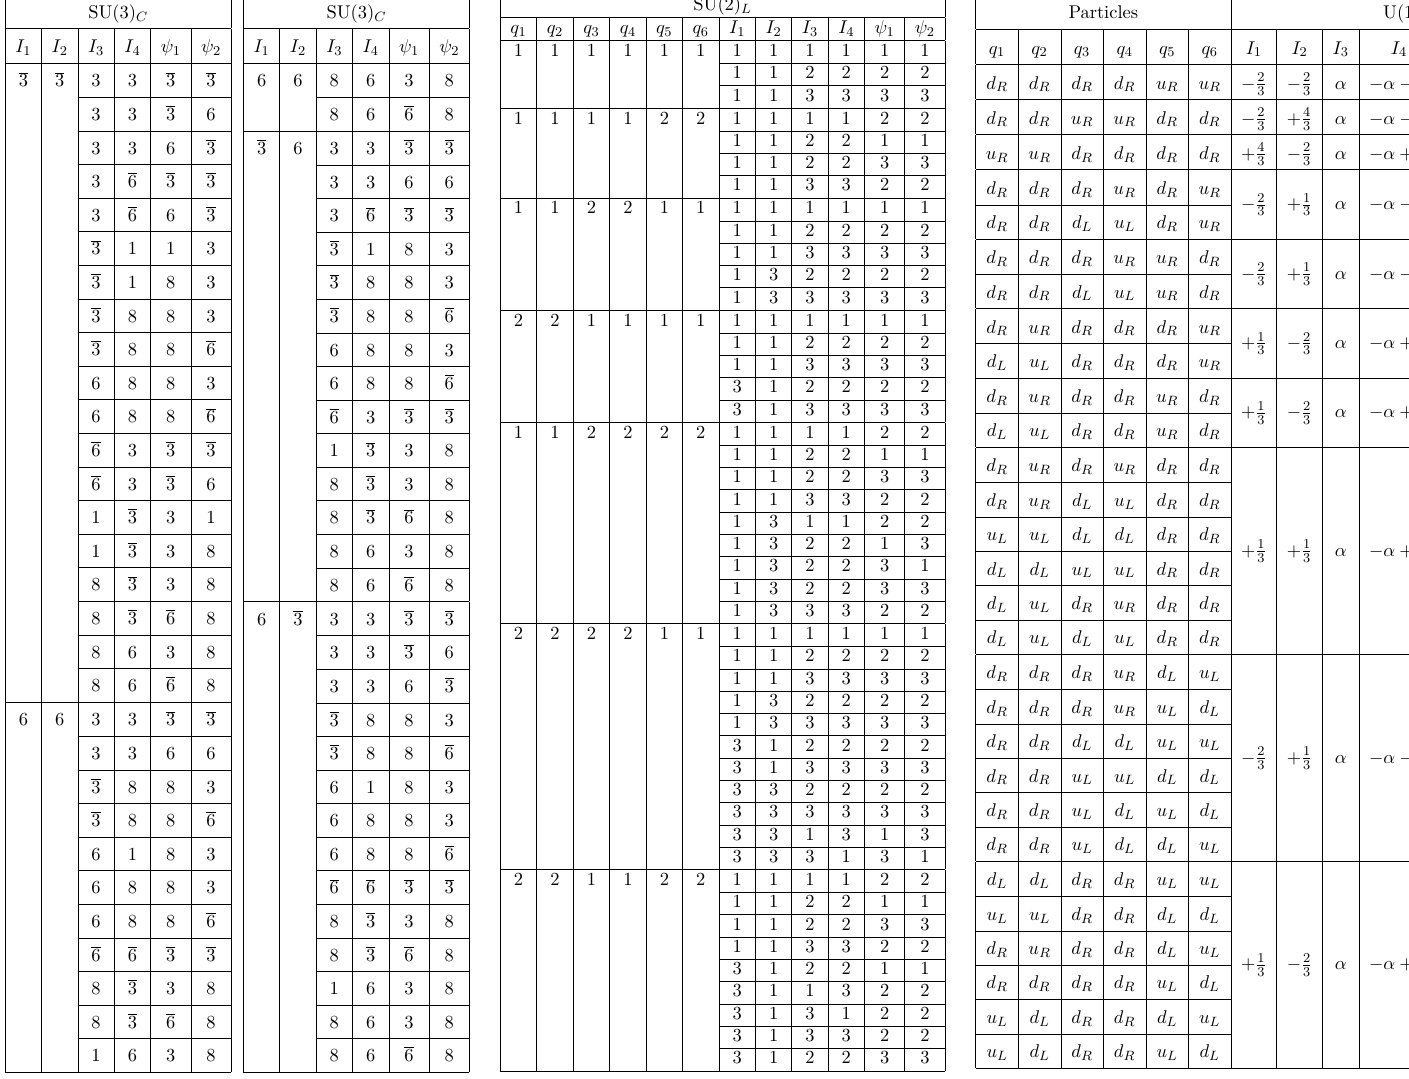
Table 6 . The possible quantum numbers of the fields in